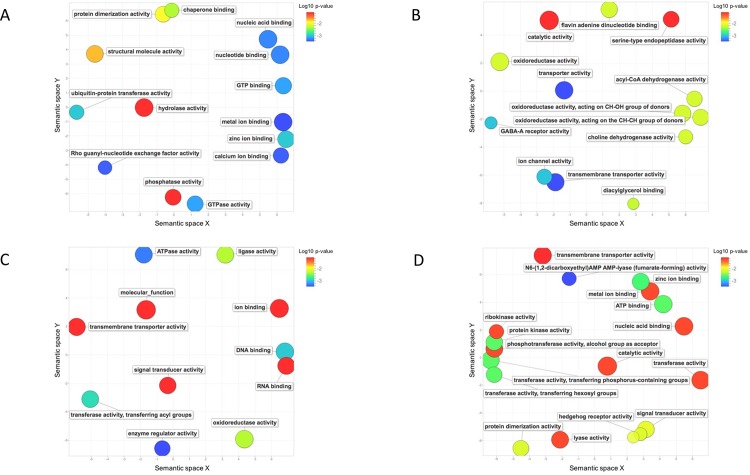
Molecular functions of significantly expressed D. noxia transcript clusters up-regulated by biotype 1 (A) or 2 (B); and down-regulated by biotype 1 (C) or 2 (D) after ingesting phloem sap from wheat plants containing the biotype 1-resistant, biotype 2-susceptible Dn4 gene compared to susceptible plants containing Dn0.Bubble color indicates p-value (legend in upper right-hand corner), bubble size indicates GO term frequency. See Methods Section for explanation of plot derivation.